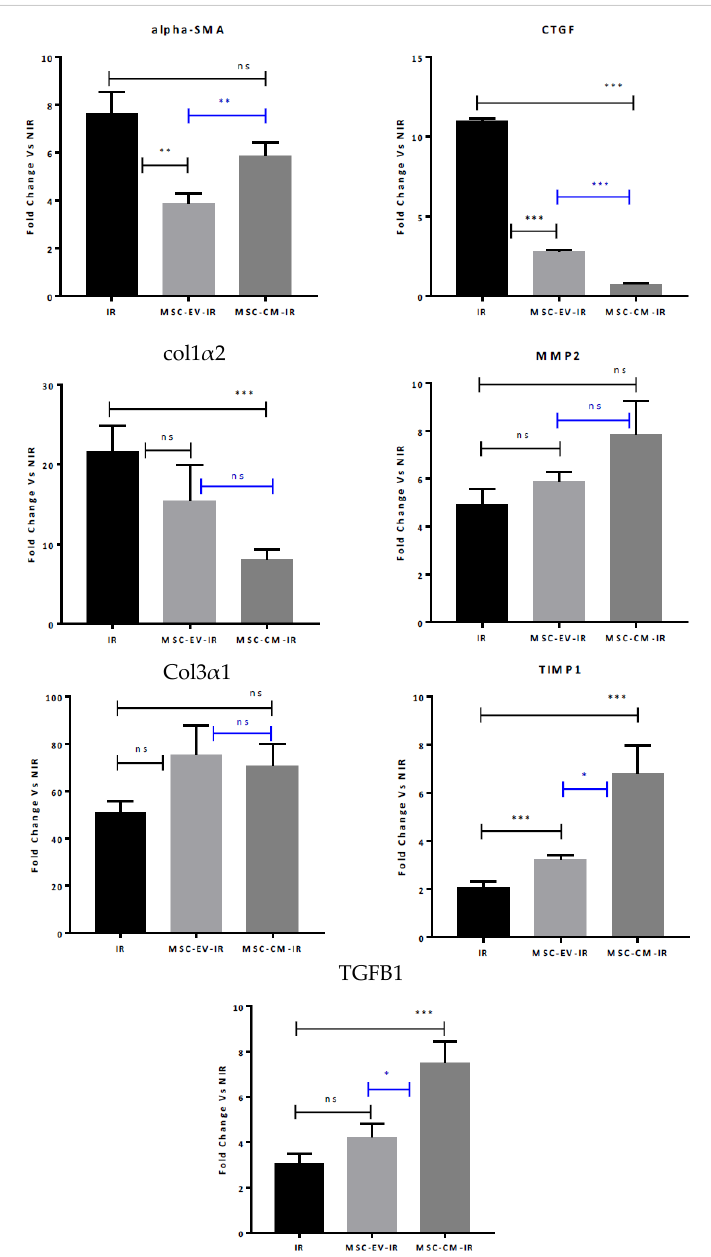
Figure 7. Results of gene expression of alpha-SMA, CTGF, Col1a2, MMP2, Col3α1, TIMP1 and TGFB1 in HUFBs irradiated with no treatment (IR) and HUBFs irradiated and preconditioned with MSC-EVs (MSC-EV-IR) or MSC-CM (MSC-CM-IR). Real-time PCR was used for the analysis. The mRNA level of GAPDH gene was considered as normalizing control gene. Fold change vs. NIR (Mean +/− sem), Mann–Whitney test: p > 0.05 ns, p < 0.05 *, p < 0.01 **, p < 0.001 ***, n = 6.